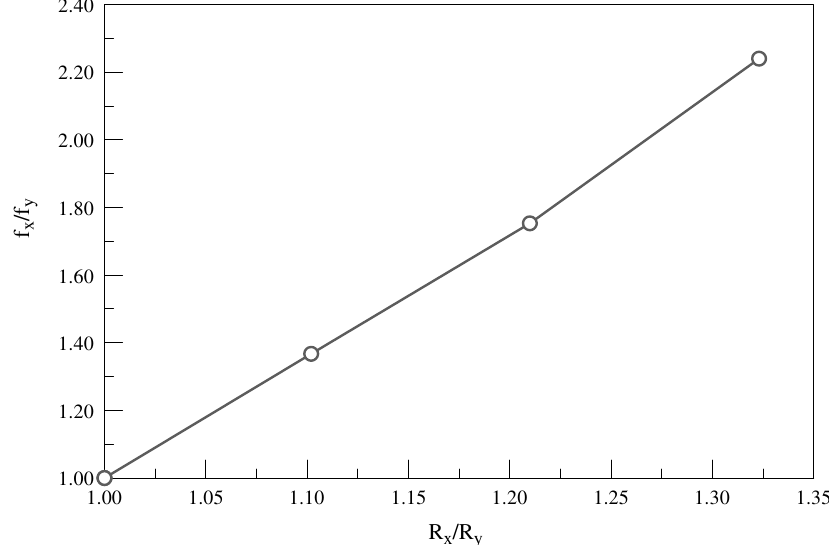
FIG. 4. Ratio of focal lengths in the horizontal and vertical directions as a function of the aspect ratio of the elliptical apertures for the baseline lens design.